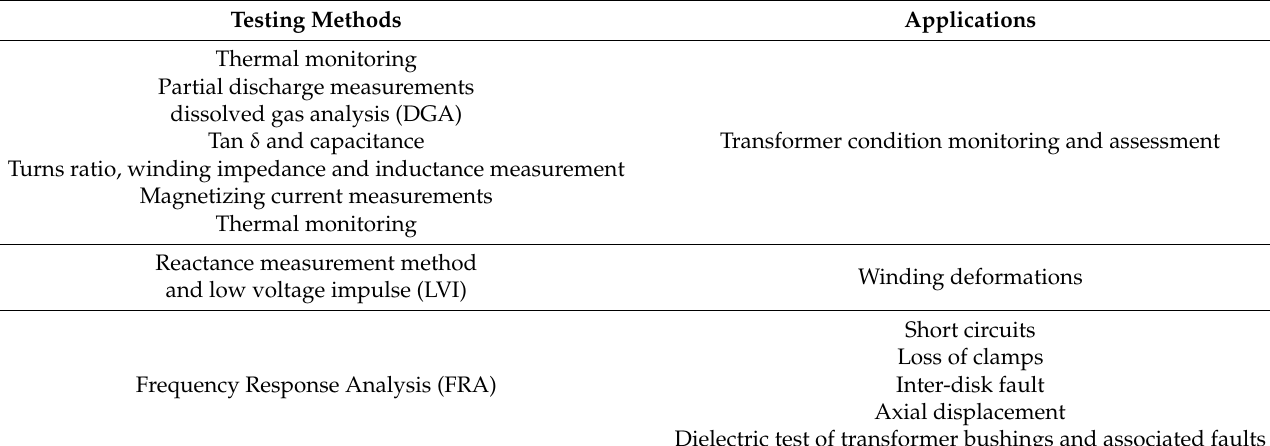
Table 9. Transformer fault testing methods and their